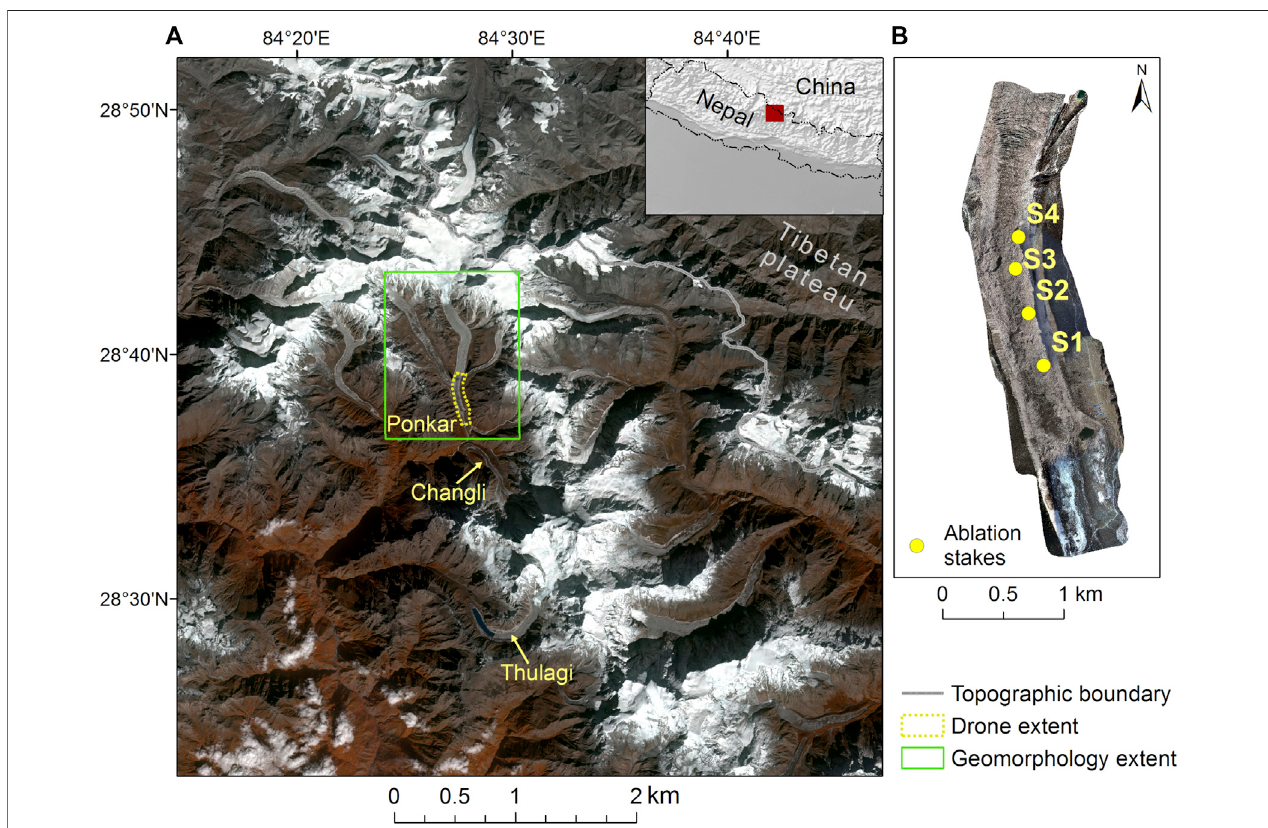
FIGURE1| LocationmapoftheManaslustudyarea,locatedintheGandakiProvinceofNepal (A) Falsecolourcomposite(bands5,4,3)ofRapidEyesatelliteimage acquiredonNovember20th,2019showingtheglaciersdiscussedinthetext; (B) OrthophotofromoftheUAVsurvey(dashedyellowpolygonin (A) ).Thegreenrectangle shows the extent of the geomorphology analysis on Ponkar Glacier (see Figure 8